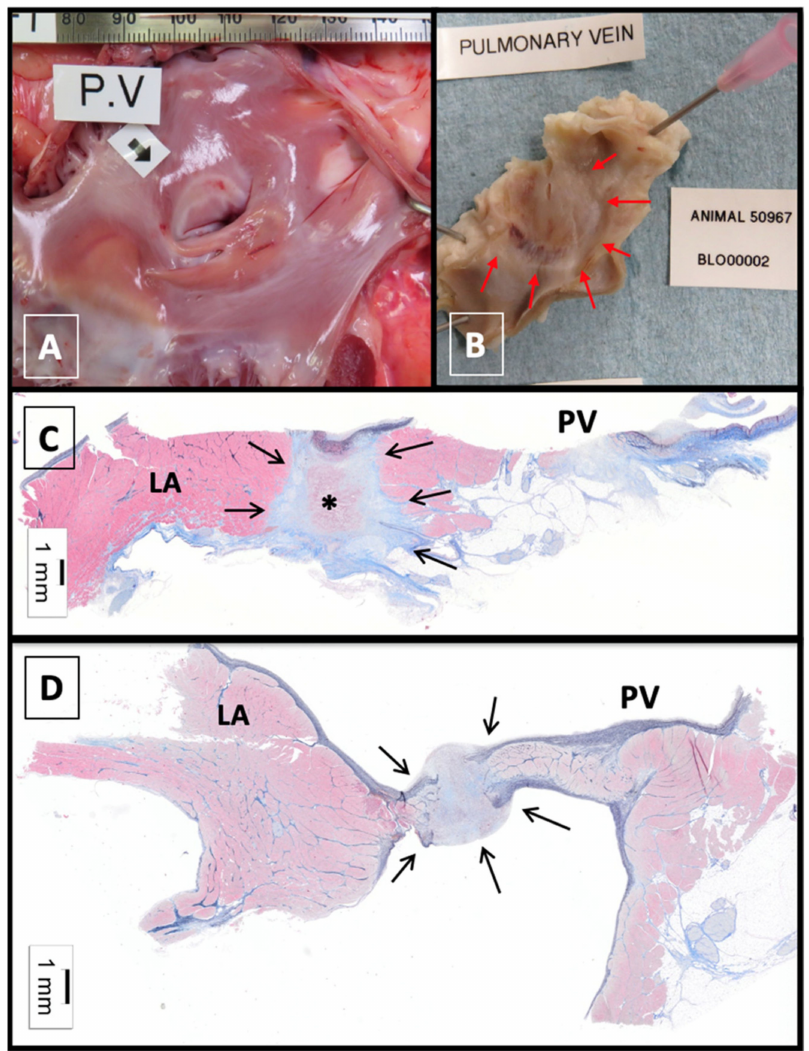
Figure 2. Study examining safety and efficacy of Cardiofocus X3 catheter in a swine model simulating isolation of right superior pulmonary vein in clinical use. Ablation performed with energy delivery in Rapid Mode at maximum 15 Watt power level around the pulmonary vein’s entire circumference following inflation of the balloon of the ablation catheter just to the point at which the balloon has no wrinkles. Panels show chronic necropsy and histologic findings after ablation using HeartLight X3 endoscopic ablation system in the vivo swine model, Day 34. ( A ) Ex vivo sample at necropsy after triphenyl-tetrazolium chloride staining. Black arrow indicates circumferential ablation at the pulmonary vein ostium. Treated area is sharply demarcated and pale without thrombus or evidence of injury at more distant tissue locations. ( B ) Formalin-fixed (unstained) sample with pulmonary vein ostium opened to expose well-demarcated treatment zone (red arrows). ( C , D ) Hematoxylin and eosin and Masson’s trichrome stained sample, Day 34, Pulmonary vein. Arrows indicate well-demarcated, transmural focus of ablation which contains residual focus of necrotic myocardial/medial tissue at center (asterisk). Images used with permission from